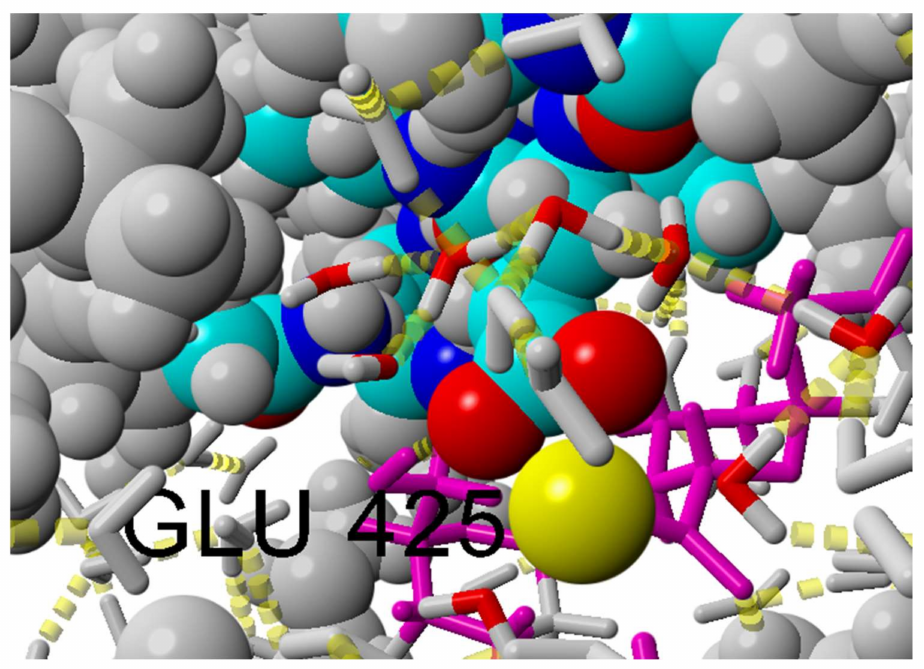
Figure 10. Water bridge visualization.